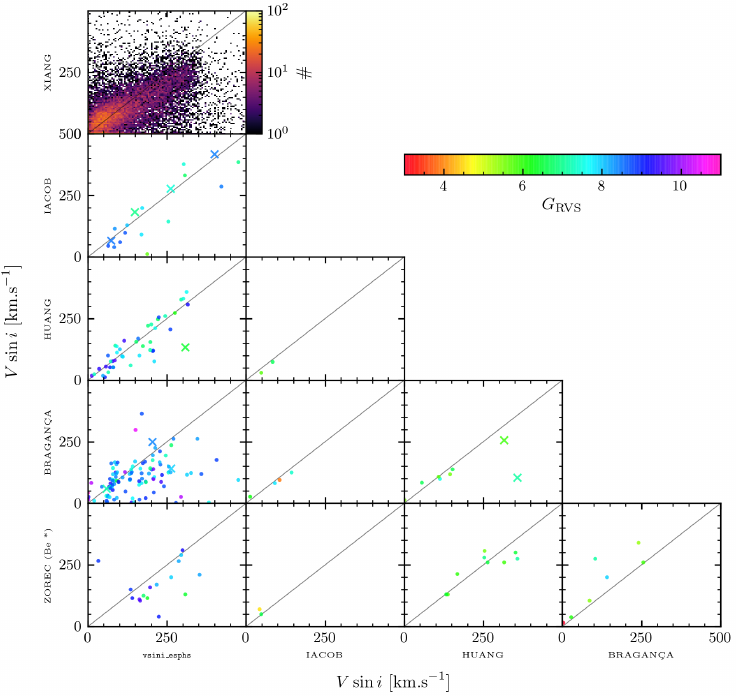
Figure 23. Comparison of the Gaia DR3 vsini_esphs estimates obtained for B- and O-type stars with measurements found in various catalogs as noted by the axis labels: XIANG [362], IACOB [358,360], HUANG [353], BRAGANÇA [355], and ZOREC [127]. The color code usually follows the G RVS (see corresponding color bar), except for the XIANG vs. vsini_esphs panel where the data were sampled into 5 kms − 1 bins. In the IACOB, HUANG, and BRAGANÇA plots, the crosses highlight those targets known, according to Simbad (CDS), for showing emission-lines. In these comparisons, we only took into account those targets with T eff ≥ 10,000